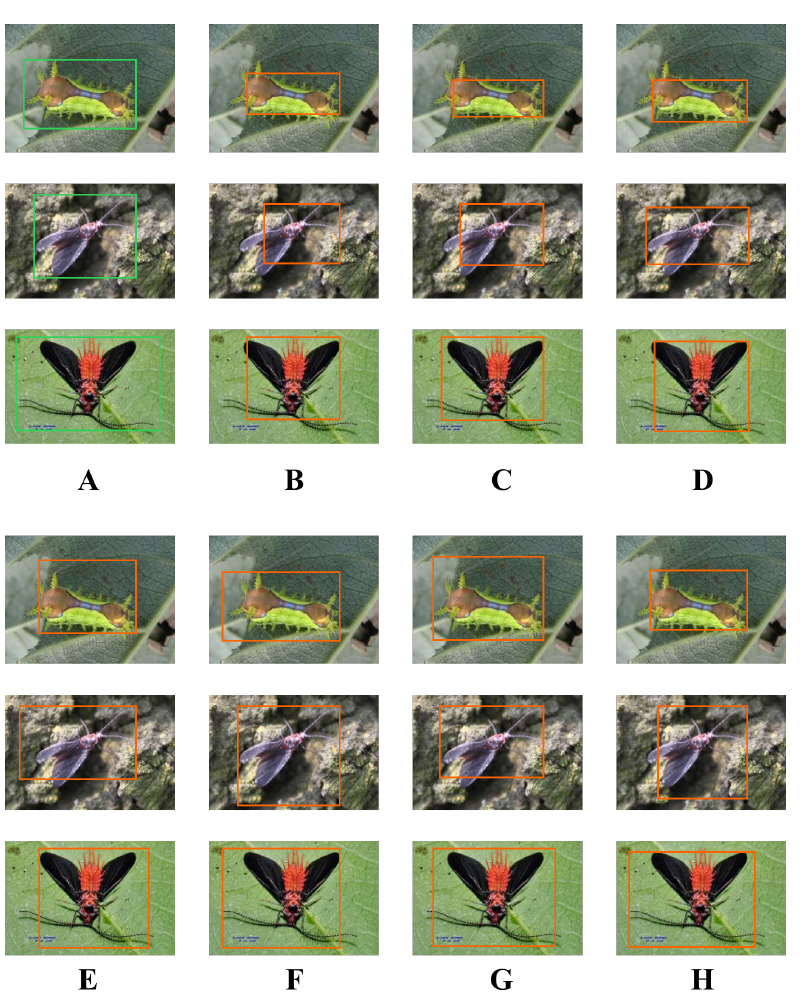
Figure 6. The detection results of other models. ( A ) is the groundtruth; ( B ) is the MobileNet; ( C ) is the Faster-RCNN; ( D ) is the SSD; ( E ) is the RefineDet; ( F ) is the EfficientDet; ( G ) is the YOLOv3; ( H ) is the YOLOv5.